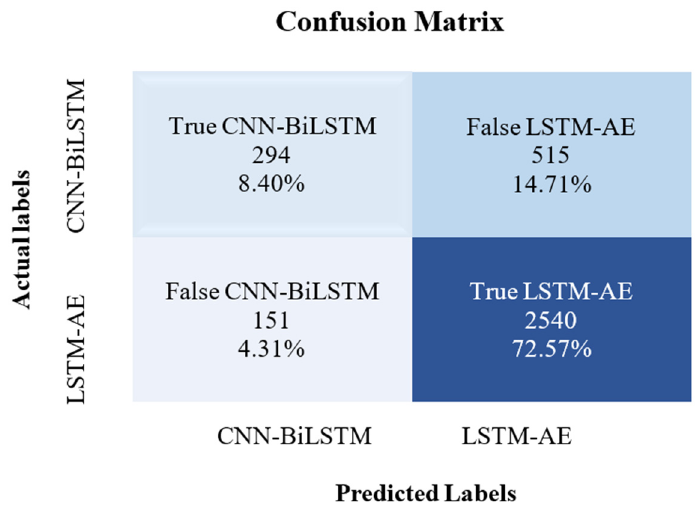
Figure 32. Auto-Selective Model Prediction Engine confusion